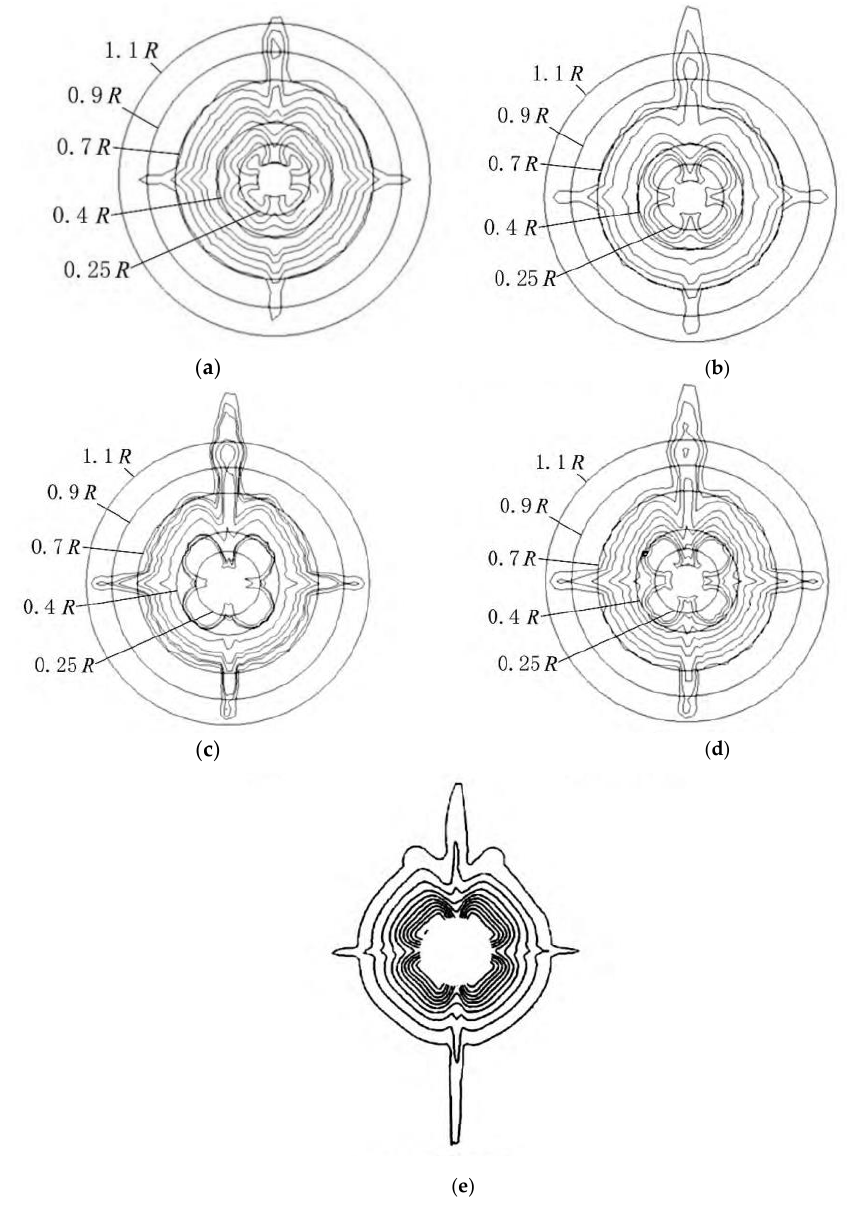
Figure 3. The submarine tail flow of different y+ values and the experimental test. ( a ) y+ < 50; ( b ) y+ < 100; (c) y+ < 250; ( d ) y+ < 300; ( e ) the experimental test.